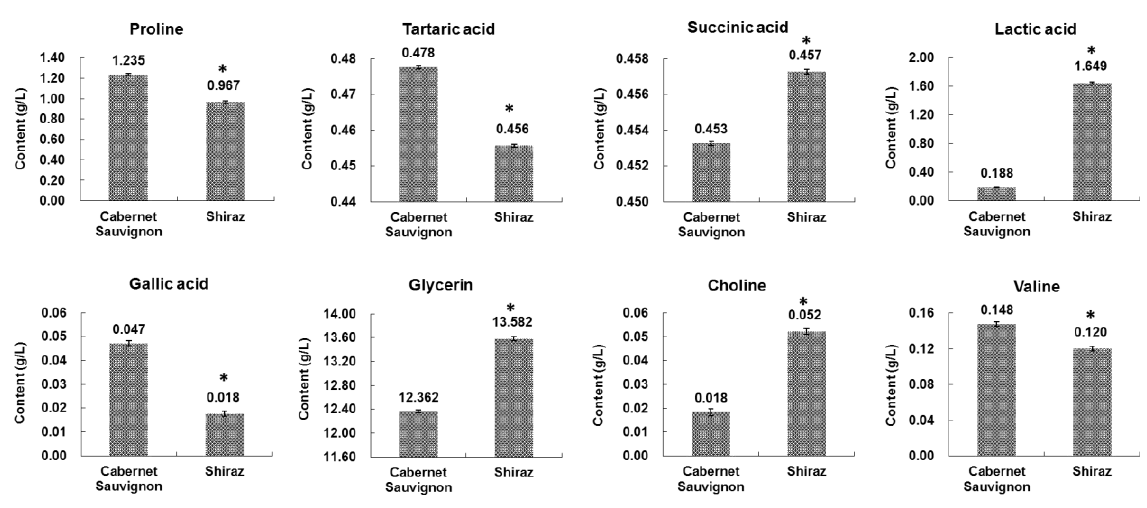
Figure 6: Content of the main metabolites in Cabernet Sauvignon and Shiraz dry red wines. Asterisks indicate the significant difference (p < 0.05) between the metabolite content of Cabernet Sauvignon and Shiraz dry red